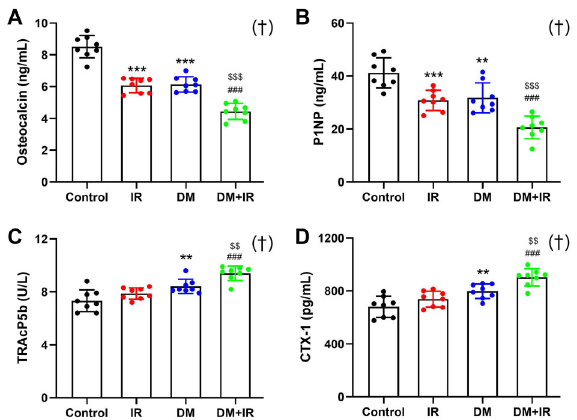
Figure 2. Effects of focal irradiation on serum concentrations of bone turnover markers in streptozotocin-treated diabetic rats or non-diabetic rats. A and B , Quantitative analysis of bone formation markers, including osteocalcin and N-terminal propep- tide of type 1 procollagen (P1NP) in the Control, irradiation (IR), diabetes mellitus (DM), and DM + IR rats. C and D , Quantitative analysis of bone resorption markers, including tartrate-resistant acid phosphatase 5b (TRAcP5b) and C-telopeptide of type I collagen (CTX-I) in the Control, IR, DM, and DM + IR groups. Data are reported as means ± SD (n=8). **P o 0.01, ***P o 0.001 vs the Control group; ### P o 0.001 vs the IR group; $$ P o 0.01, $$$ P o 0.001 vs the DM group; w interactions between DM and IR